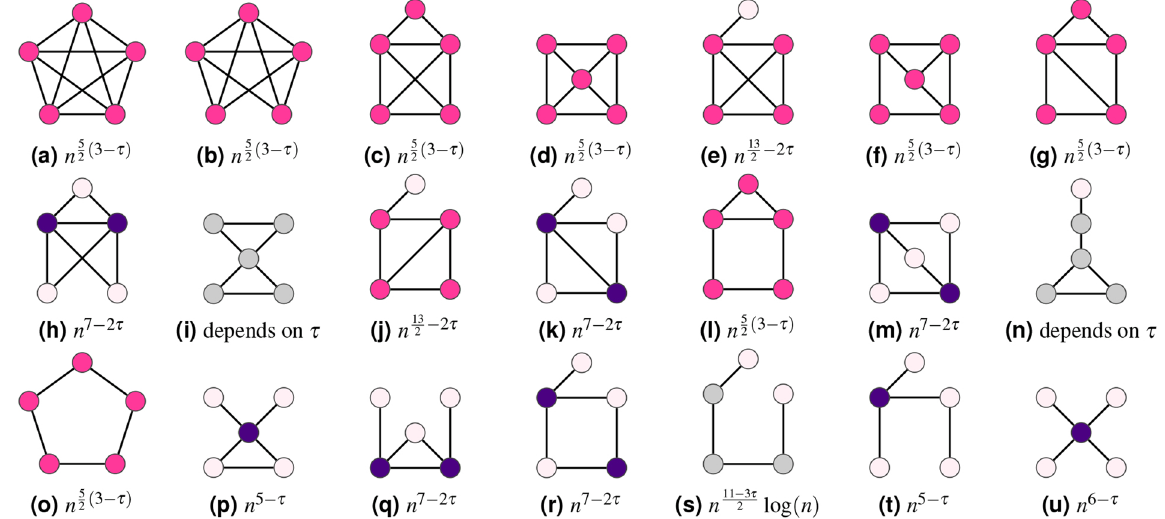
Figure 2. Scaling of the expected number of motifs on 5 vertices in n , where the vertex color indicates the dominant vertex degree, as in Fig. 1.